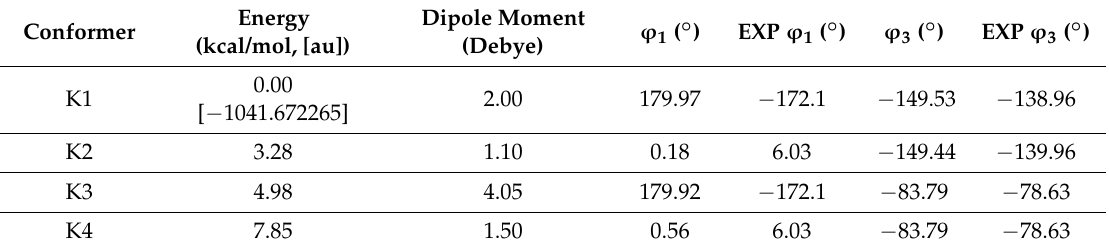
Table 3. Calculated values of energy, electric dipole moments and torsion angles for particular conformers. Reference total energy of K1 contains ZPE correction (+0.4